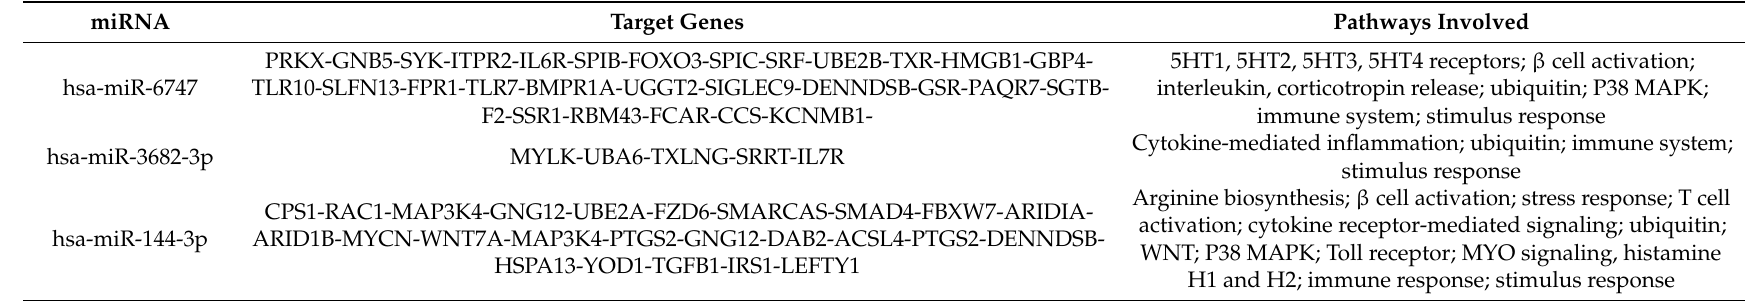
Table 3. In silico analysis of repressed microRNAs with the highest fold change and some target genes and pathways